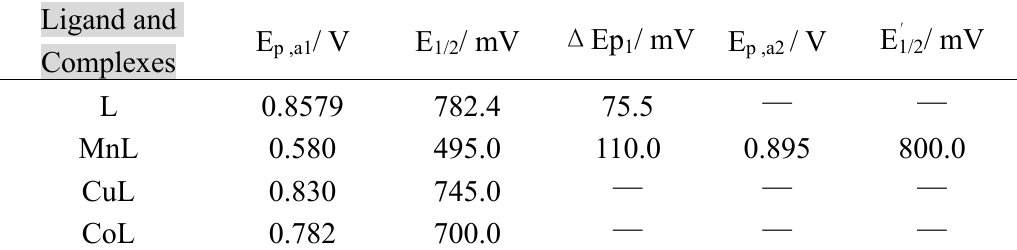
Figure 3. Cyclic Voltamogram of the Complexes in CH